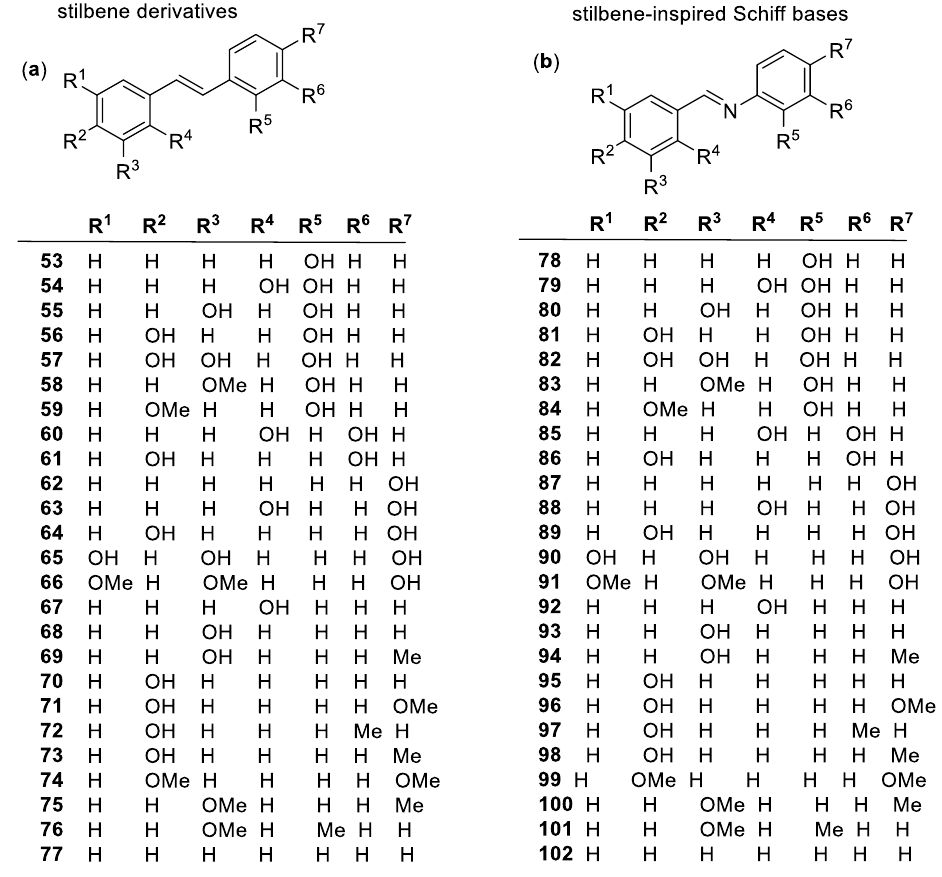
Figure 6. The structure of stilbene derivatives ( a ) and stilbene-inspired Schiff-bases ( b ) with reported antioxidant activity.